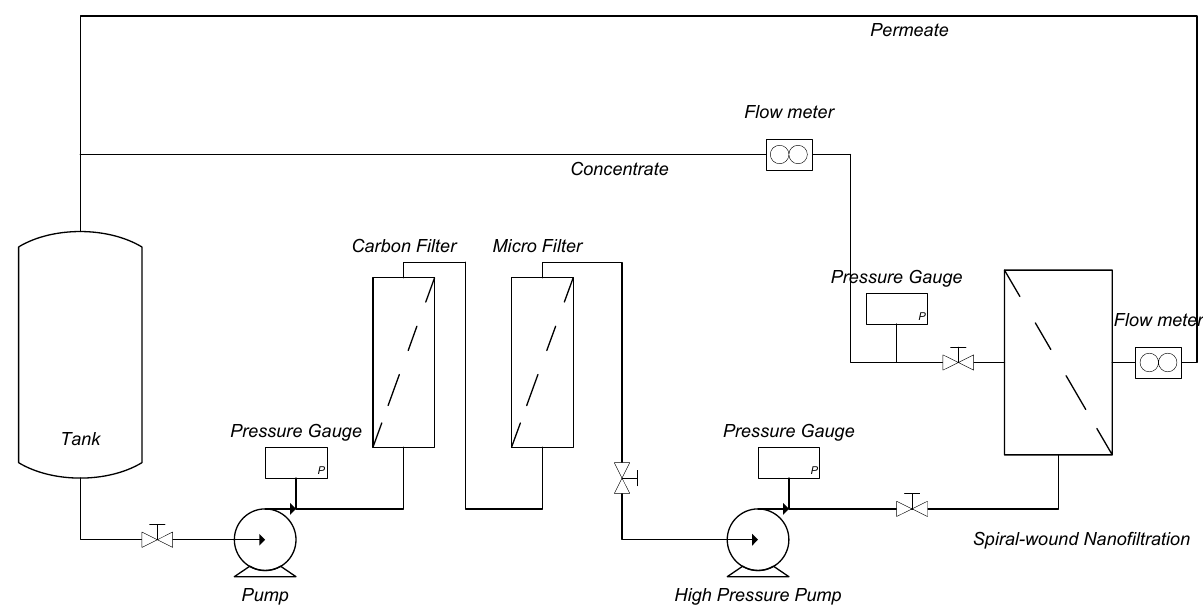
Figure 1. Schematic of the experimental